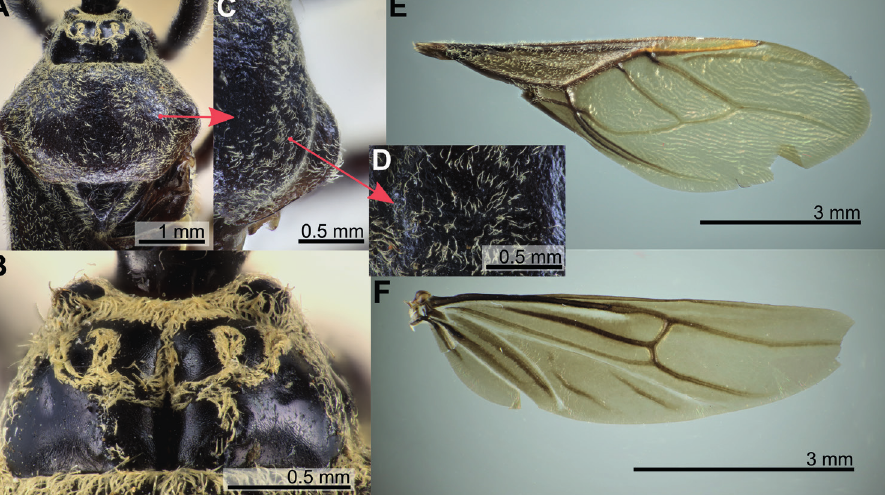
Figure 14. Biasticus taynguyenensis Ha, Truong & Ishikawa, sp. nov., holotype, ♀ , HNL2018-073 A pronotum in dorsal view B anterior pronotal lobe in dorsal view C, D setae on posterior pronotum E right hemelytron F right hind